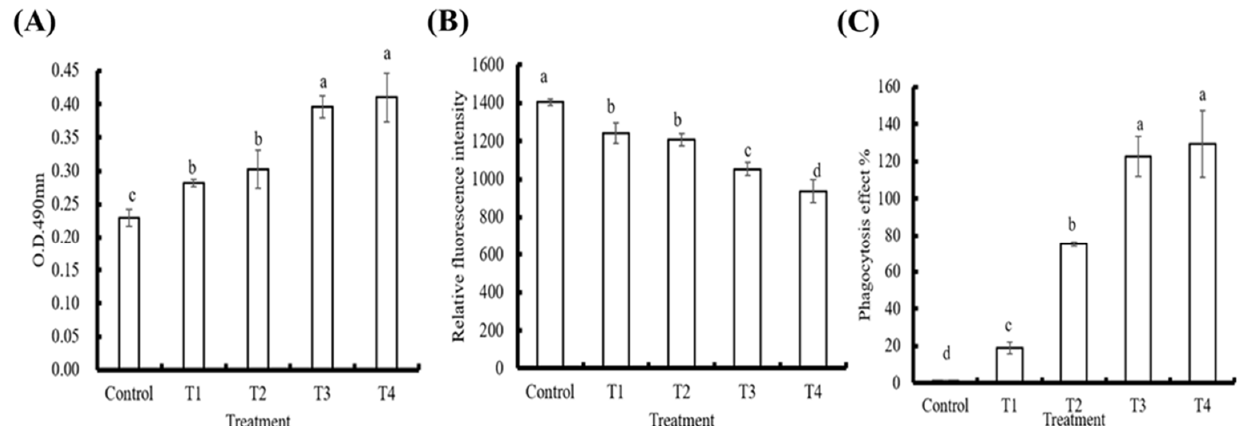
Figure 5. The effects of different phycoerythrin doses on the immune indices of hemocytes. The ( A ) prophenoloxidase activity, ( B ) reactive oxygen species production, and ( C ) phagocytosis activity in hemocytes of whiteleg shrimp ( Litopenaeus vannamei ) were examined after treating hemocytes with various doses of purified phycoerythrin (T 1 , T 2 , T 3 , and T 4 represent treatments of 8, 14, 27, and 52 µ g/mL, respectively). Data are presented as the mean ± standard error of mean ( n = 5). Significant differences ( p < 0.05, one-way ANOVA and Tukey’s post hoc test) are expressed by different letters. O.D., optical density; RFU, relative fluorescence units.